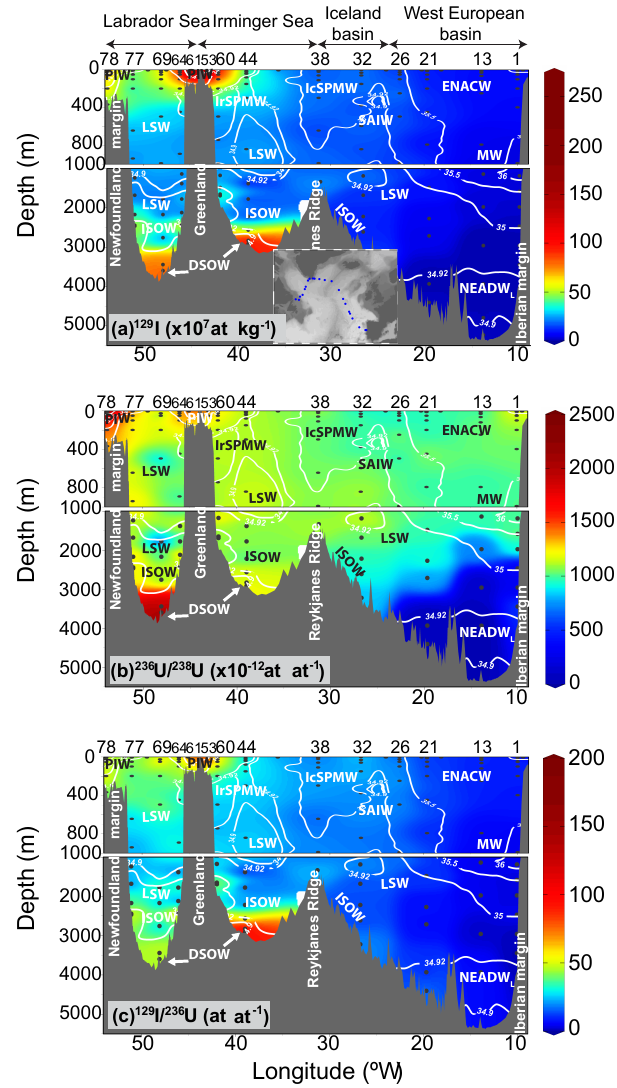
Figure 3. Vertical distribution of (a) 129 I concentrations, and atom ratios of (b) 236 U / 238 U and (c) 129 I / 236 U during the GEOVIDE cruise in spring 2014. Isohalines are overlaid to represent the water mass distribution. Acronyms are defined in the